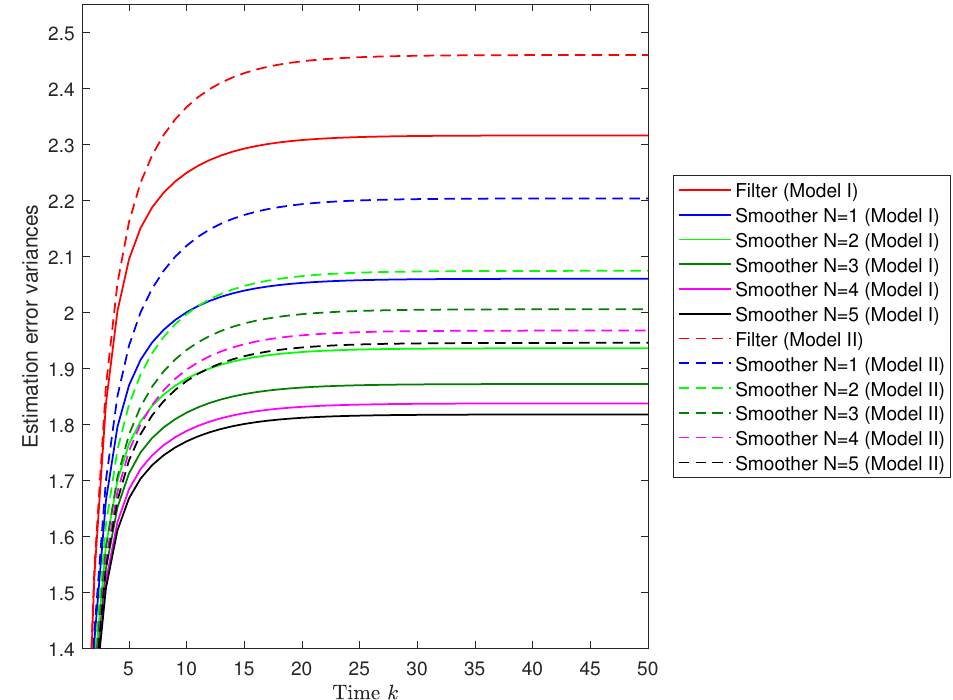
Figure 2. Error variance comparison of the centralized fusion filtering and smoothing estimators considering observations from Model I and Model II.